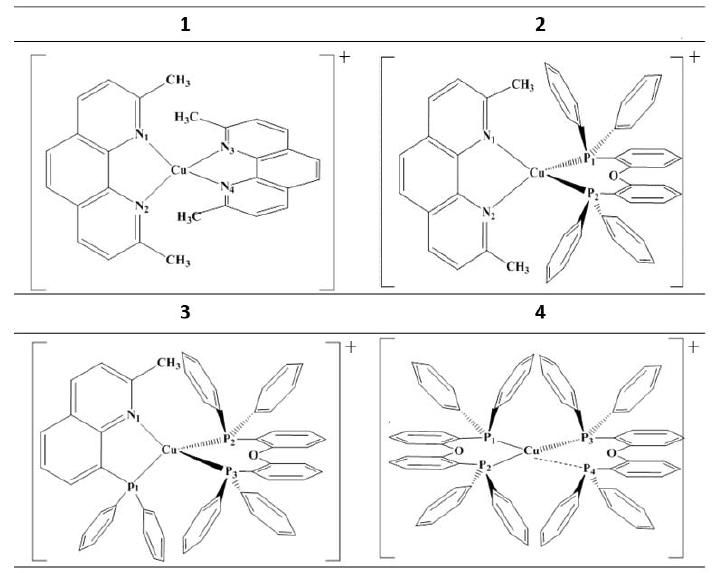
Figure 1. Chemical structures of the studied complexes.